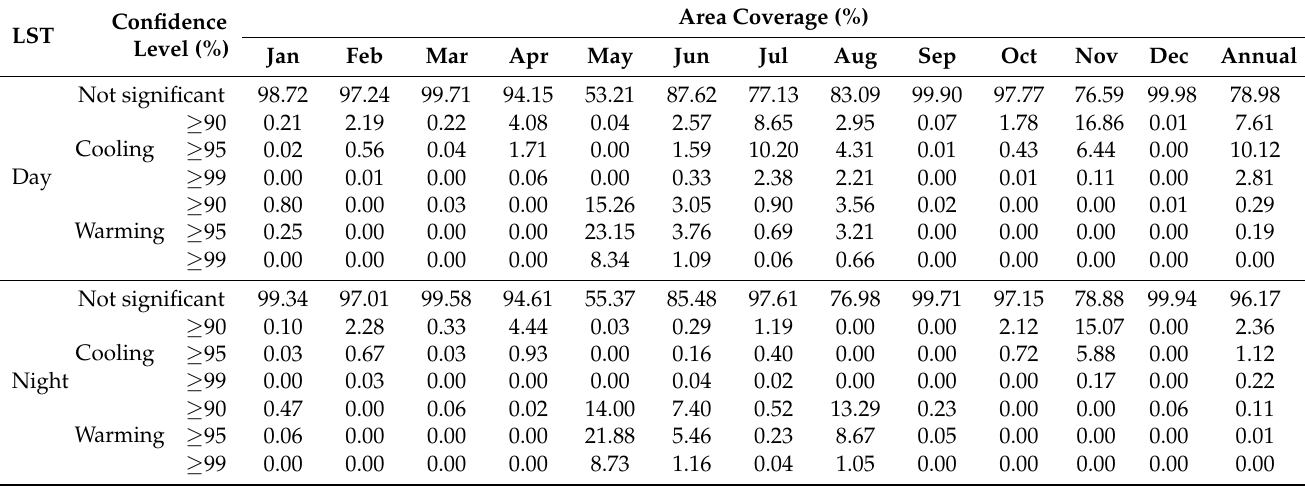
Figure 2. Comparison of Sen’s slope for the daytime and nighttime LST. Table 3. Area coverage in percentage warming and cooling trends for over 90% confidence levels.